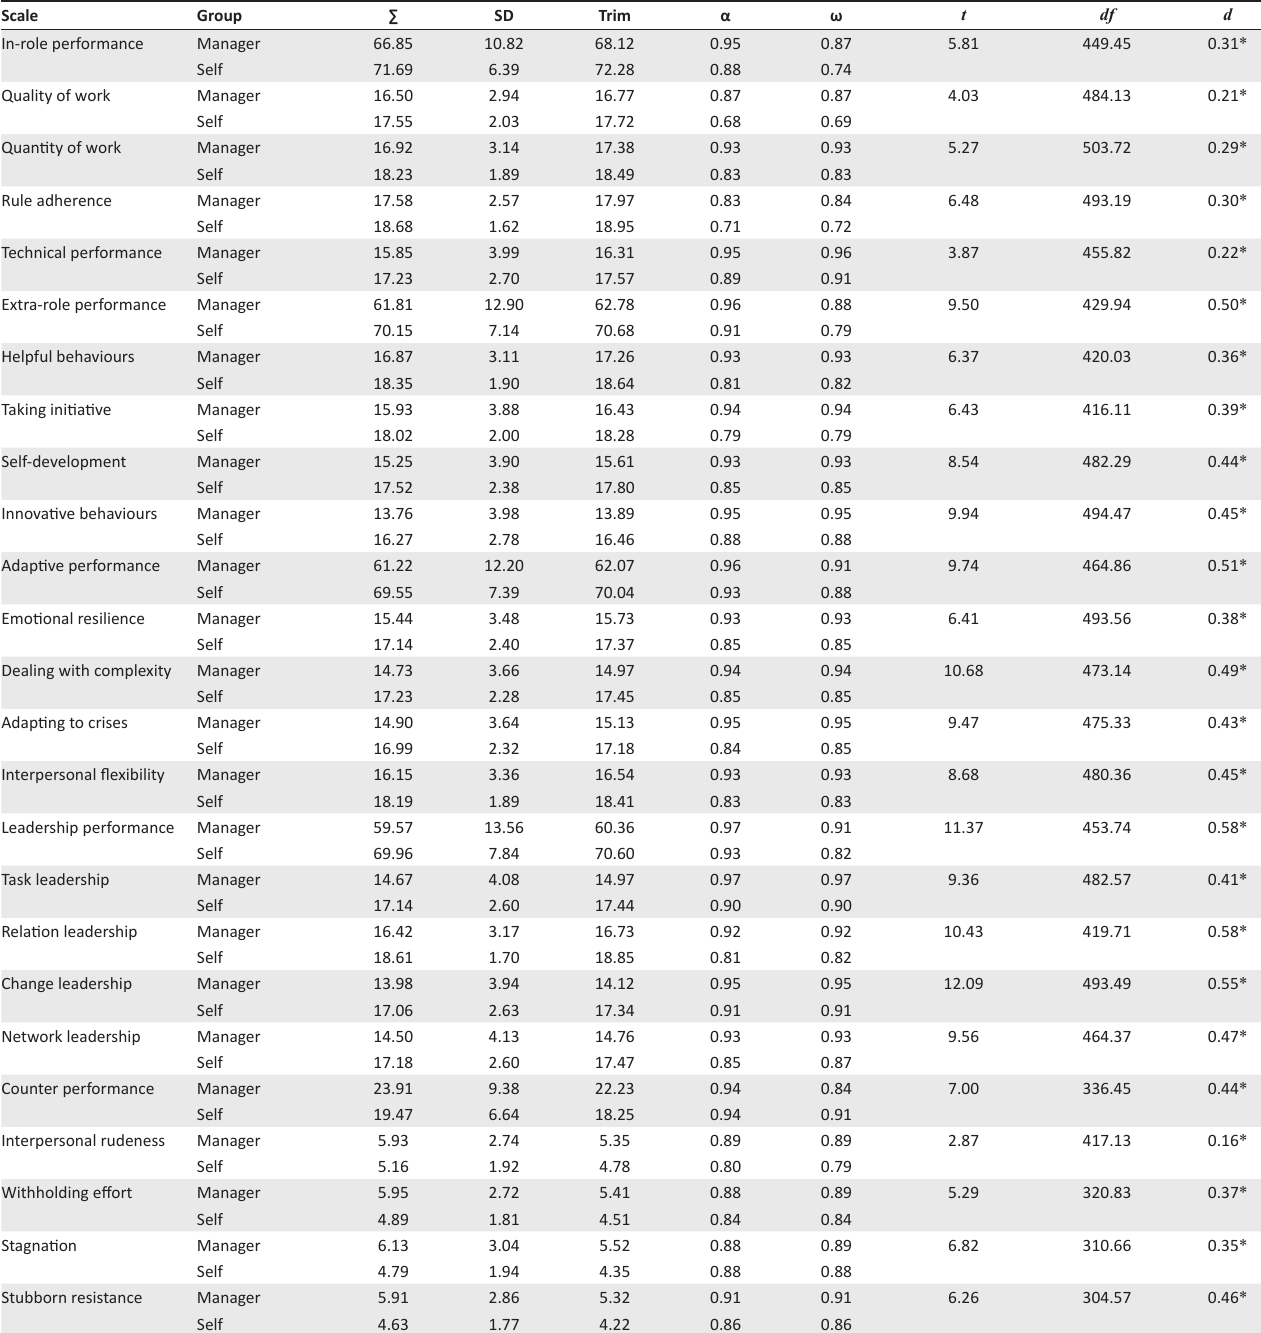
TABLE 4: T -test results, narrow performance scale means, standard deviations, and reliability coefficients per rating group. Scale